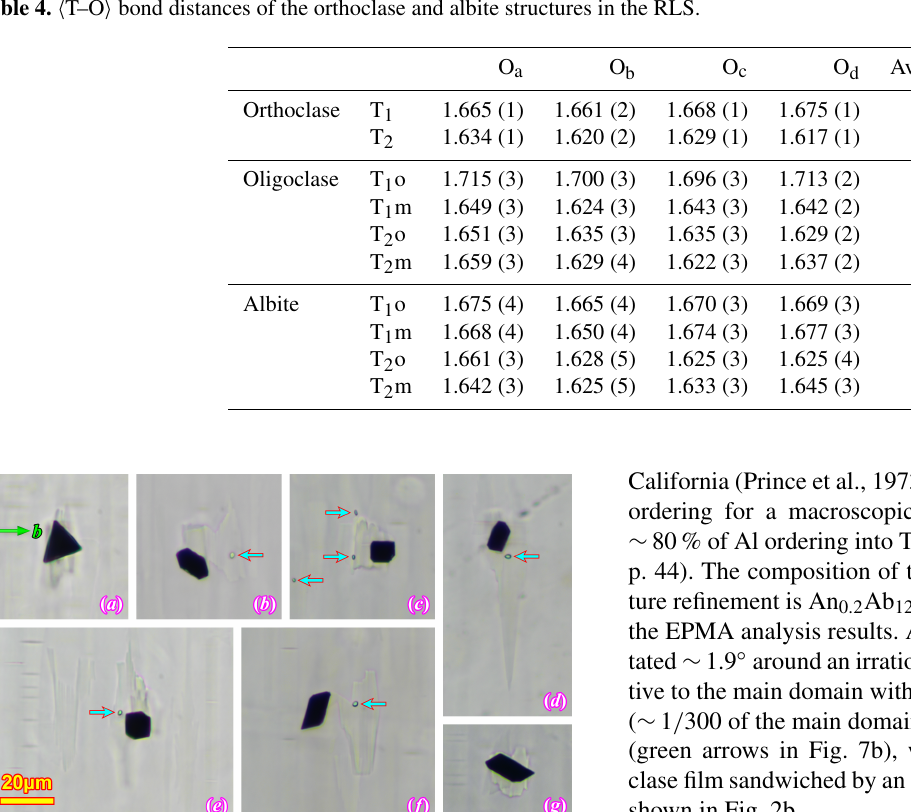
Table 4. (cid:104) T–O (cid:105) bond distances of the orthoclase and albite structures in the RLS.